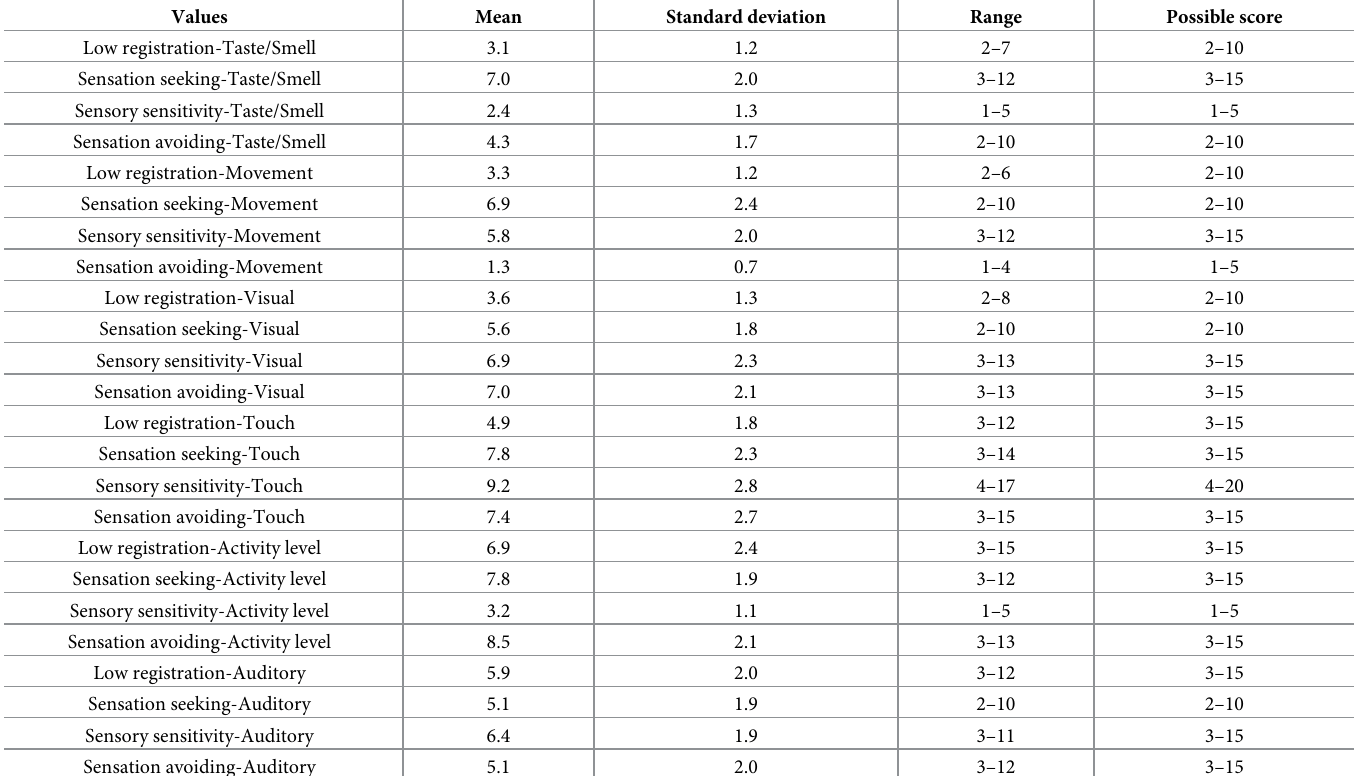
Table 2. Demographic characteristic of Adolescent/Adult Sensory Profile